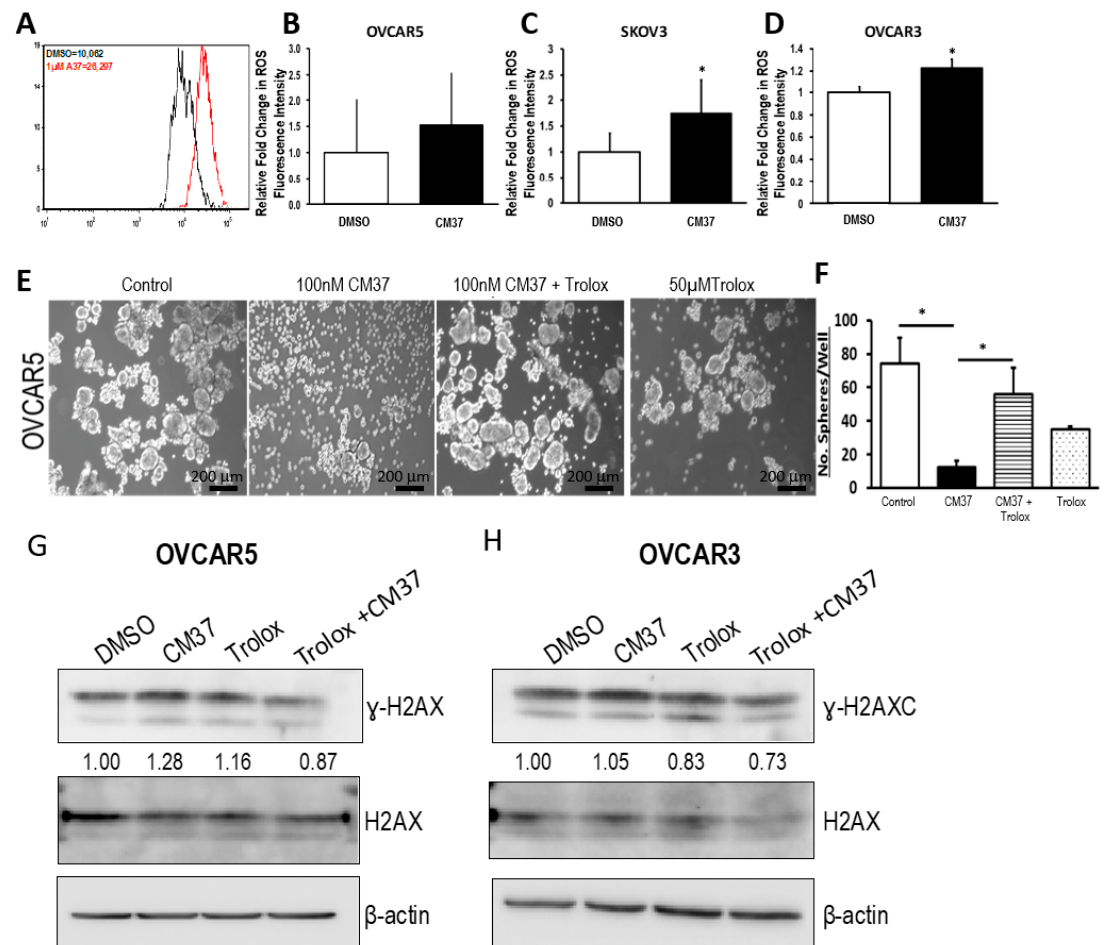
Figure 6. CM37 increases reactive oxygen species (ROS) levels in OC cells. ( A ) Representative flow cytometry for total intracellular ROS levels in OVCAR5 cells treated with DMSO or 1 µ M CM37. ( B – D ) Fold change in ROS levels measured by flow cytometry in SKOV3, OVCAR3, and OVCAR5 treated with DSMO or 1 µ M CM37 for 1 h. ( E , F ) Sphere formation in OVCAR5 cancer cells treated with 100 nM CM37 +/ − 50 µ M trolox for three days. Spheres were photographed under an inverted microscope ( E ) and counted (five fields per well; ( F ). Bars represent averages of triplicate measurements; * corresponds to p < 0.05. ( G , H ) Western blot measures γ H2AX, H2AX, and β -actin protein levels in OVCAR5 and OVCAR3 cells cultured as spheres for six days and treated with 5 µ M CM37 for 45 min, after 1 h or not of pre-treatment with Trolox (20 µM).